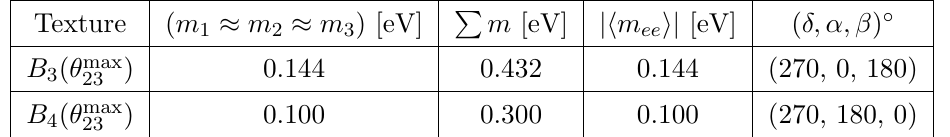
Table 8 . Simulated values for the textures B 3 ; B 4 for quasi-degenerate neutrino mass pattern.